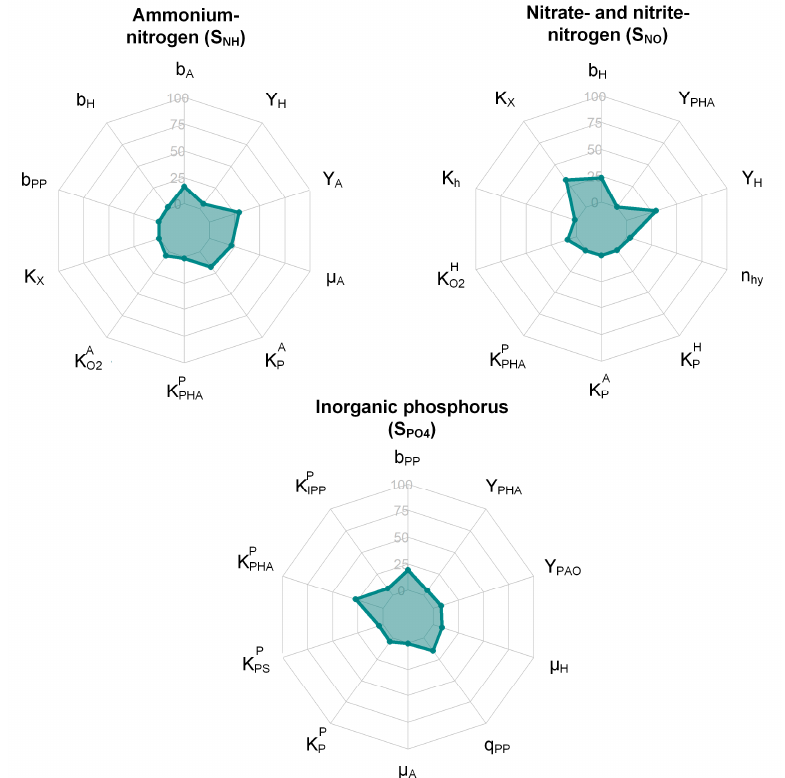
Figure 2. Ten most significant parameters influencing the variability of ammonium-nitrogen, nitrate- and nitrite-nitrogen, and phosphate in the activated sludge (AS) systems. The results in the radar graphs are the proportion of sensitivity function ( s ij ) for the state variable against the changes of each model parameter over the total sum of sensitivity measures. The description of the influential parameters in the graph can be found in the Supplementary Material F.